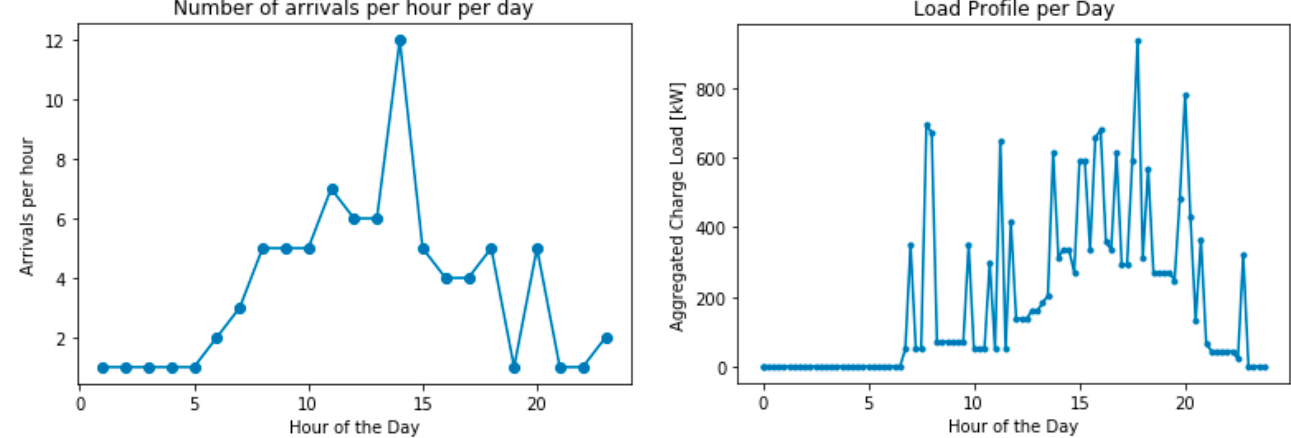
Figure 1. Results from the simulations carried in [19] showing arrival rates in one day (graph on the left) and estimated loads as a consequence of this type of arrival pattern (graph on the right). Here, an example of a future situation where demand is 4 times higher than today and where this demand is met with an extra superfast charger of 300 kW is